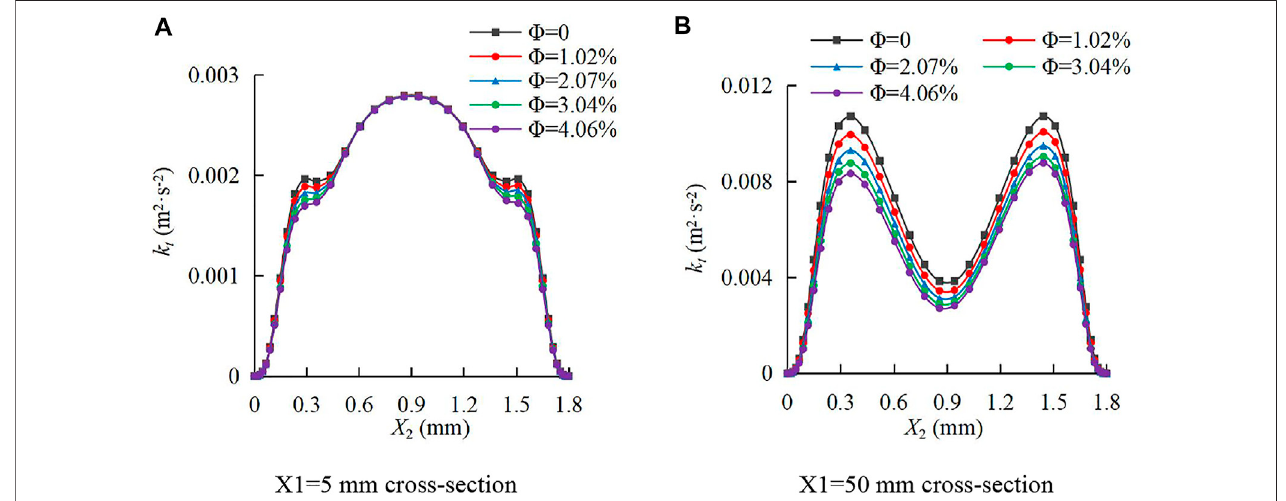
FIGURE 13 | Distribution of turbulent kinetic energy of the continuous-phase fl uid on cross sections of the smooth fracture. (A) X1=5 mm cross section; (B) X1=50 mm cross section.